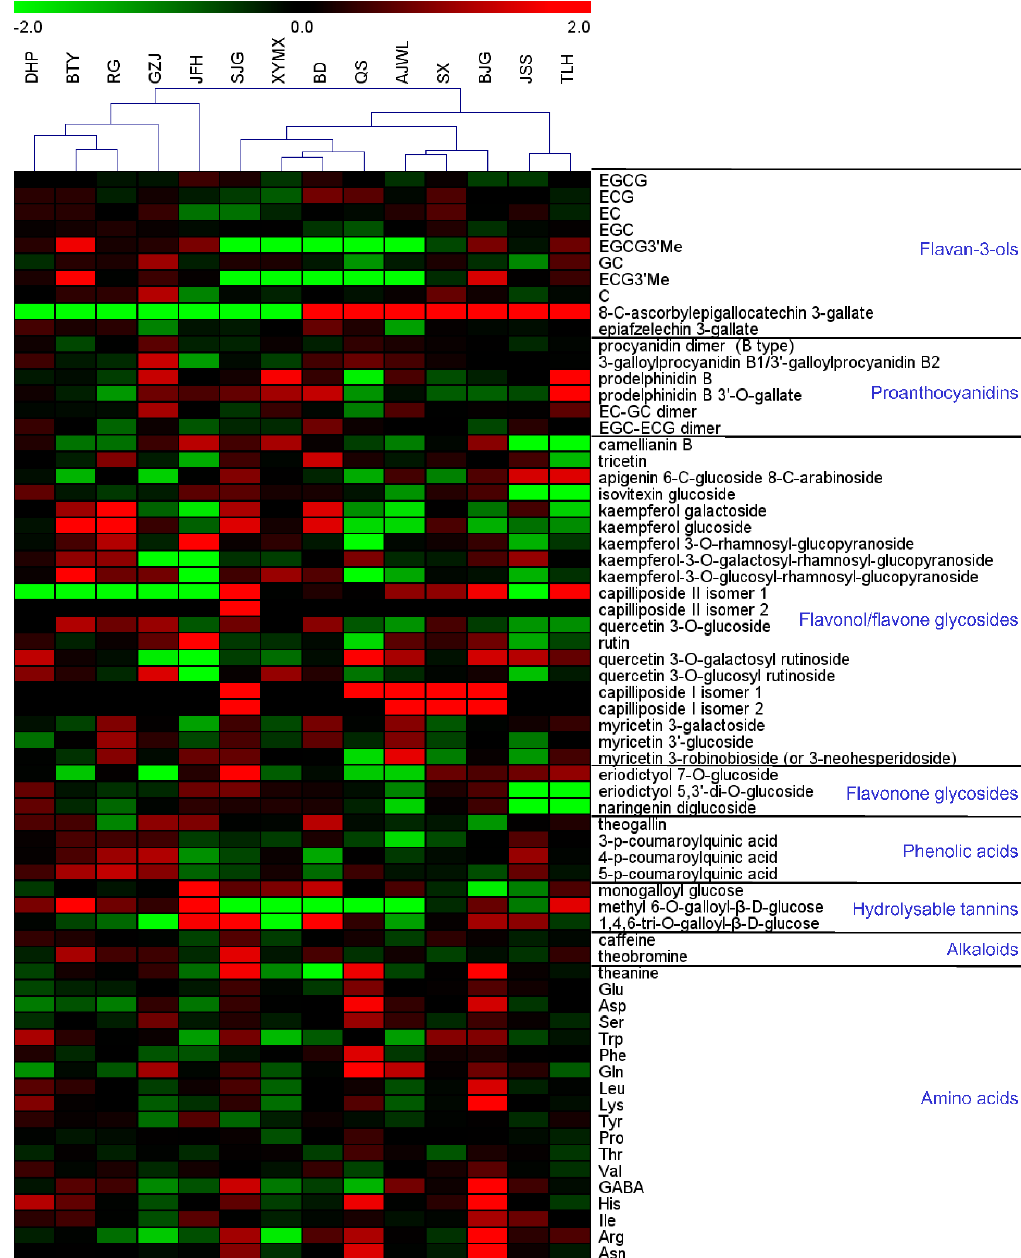
Figure 2. Comparisons of metabolite levels in 14 tea cultivars. The analysis is based on the normalized average signal abundance from three biological replicates for each cultivar. Normalized values are shown on a color scale proportional to the content of each metabolite and are expressed as log2 using the MultiExperiment Viewer software (MeV v4.9.0, J. Craig Venter Institute, La Jolla, CA, USA).